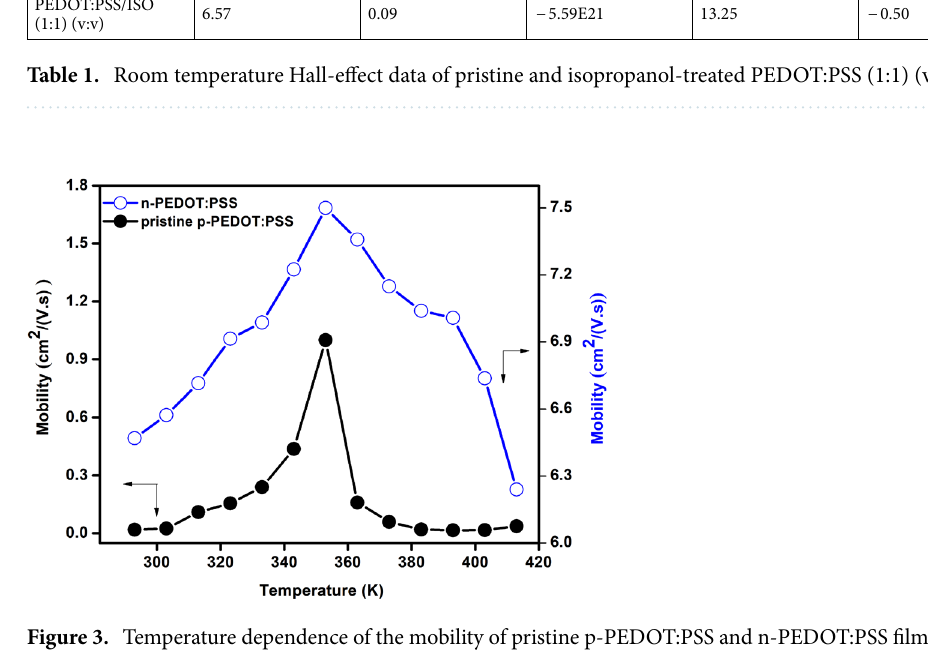
Mobility µ (cm 2 /Vs) Resistivity ρ (Ω cm)